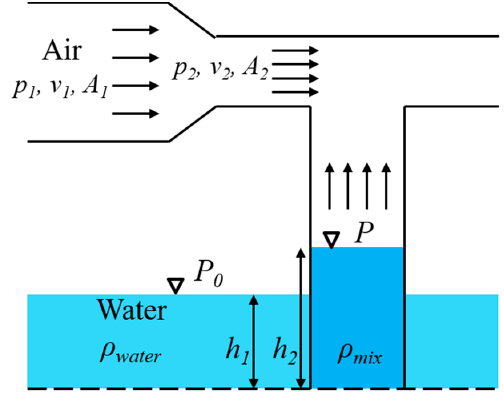
Figure 3. Schematic design of a hybrid pump.